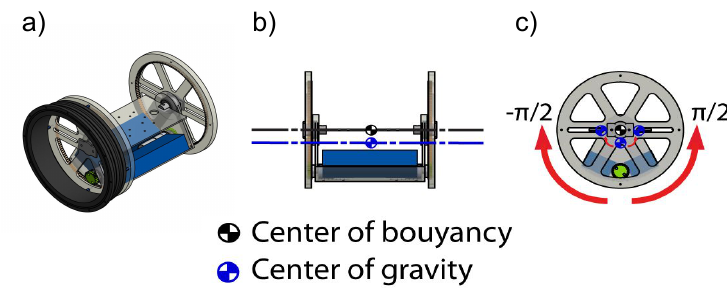
Figure 5. ( a ) Pendulum mechanism assembled in flange of watertight container ( b ) front view and ( c ) side view of pitch motion acquired by pendulum shift.